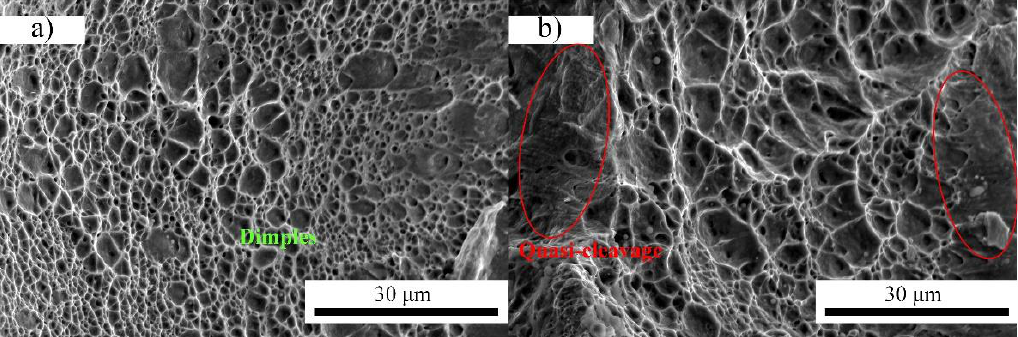
Figure 12. Slow-strain rate tensile fracture of samples D with and without hydrogen charging. ( a ) Not hydrogenated; ( b ) hydrogenated.